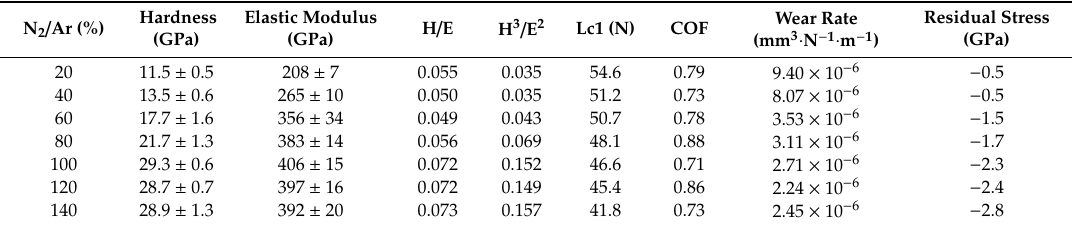
Figure 4. Hardness and Young’s modulus of CrAlN layers deposited under various N 2 /Ar flow ratios.